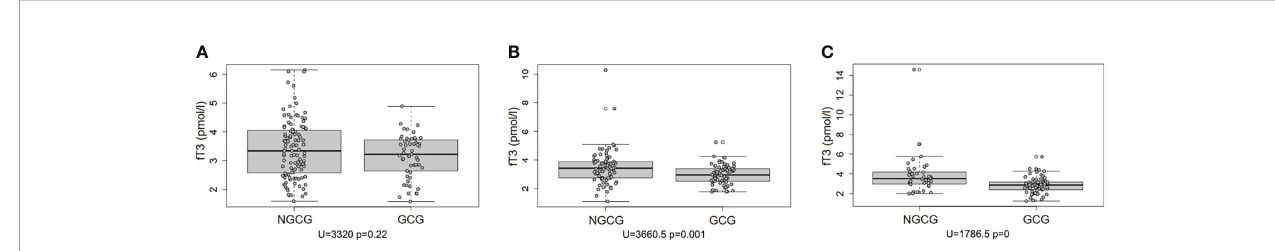
FIGURE 2 | Concentration of fT3 over three consecutive time points among patients not treated with glucocorticoids (NGCG) and treated with glucocorticoids (GCG). (A) time point #1; (B) time point #2; (C) time point #3.